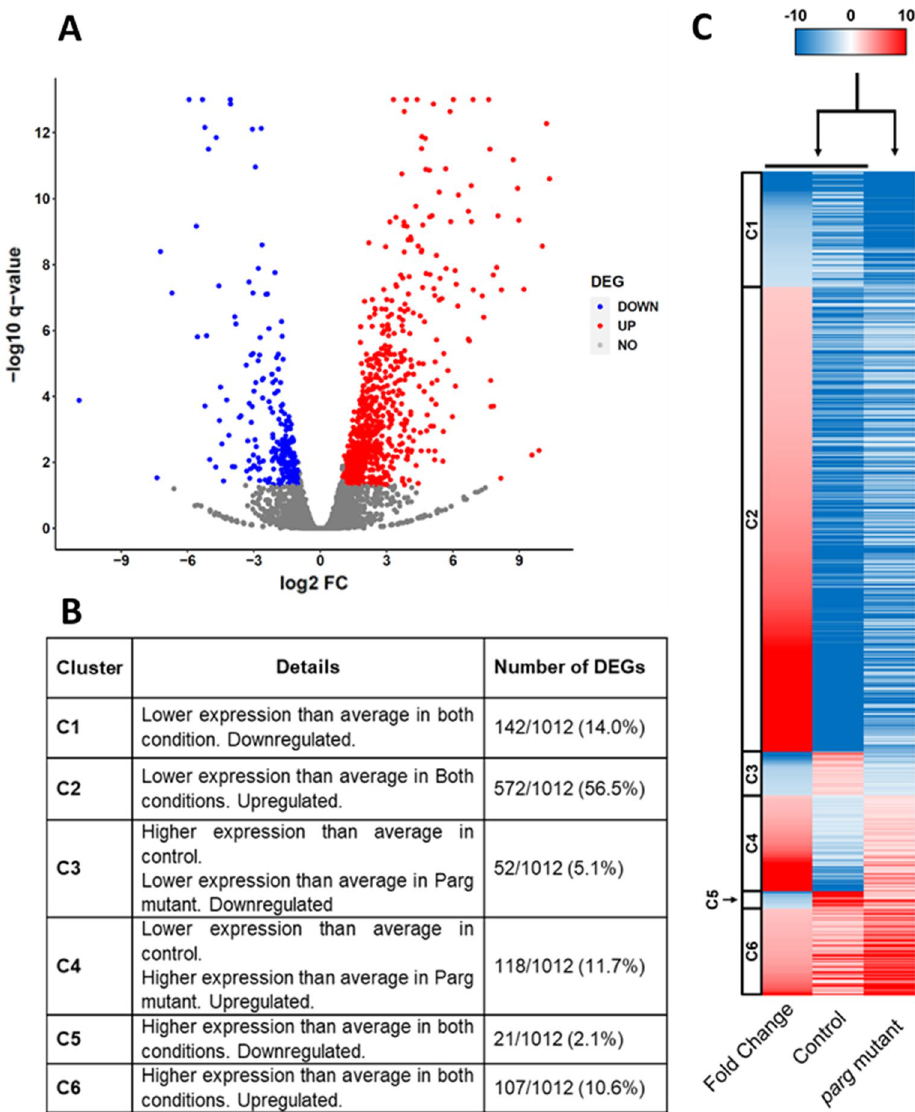
Figure 2. Expression profile is affected in the absence of PARG. ( A ) Volcano plot representing the fold change (FC) between Parg mutant and control larvae on the x-axis and the FDR-corrected p-value (q-value) of the y-axis. Significant number of downregulated genes (downregulated DEGs) are represented in blue, while a significant number of upregulated genes (upregulated DEGs) are represented in red. Genes without significant changes are represented in gray. DEG: differentially expressed genes. ( B ) Table representing the composition of the different clusters presented in Fig. 1C. Odd numbers include downregulated DEGs, while even numbers include upregulated DEGs. ( C ) Heatmap of DEGs. The blue shading of the fold change column represents downregulated DEGs, while the red shading represents upregulated DEGs. The control and Parg mutant columns represent the expression value of DEGs normalized to the average expression of all genes expressed in control or Parg mutant, respectively. For control and Parg mutant columns, blue shading represents DEGs with lower than average expression, while red shading represents DEGs with higher than average expression. Heatmap was generated with Excel 2016, available at this link: https:// www. micro soft. com/ en- us/ micro soft- 365/